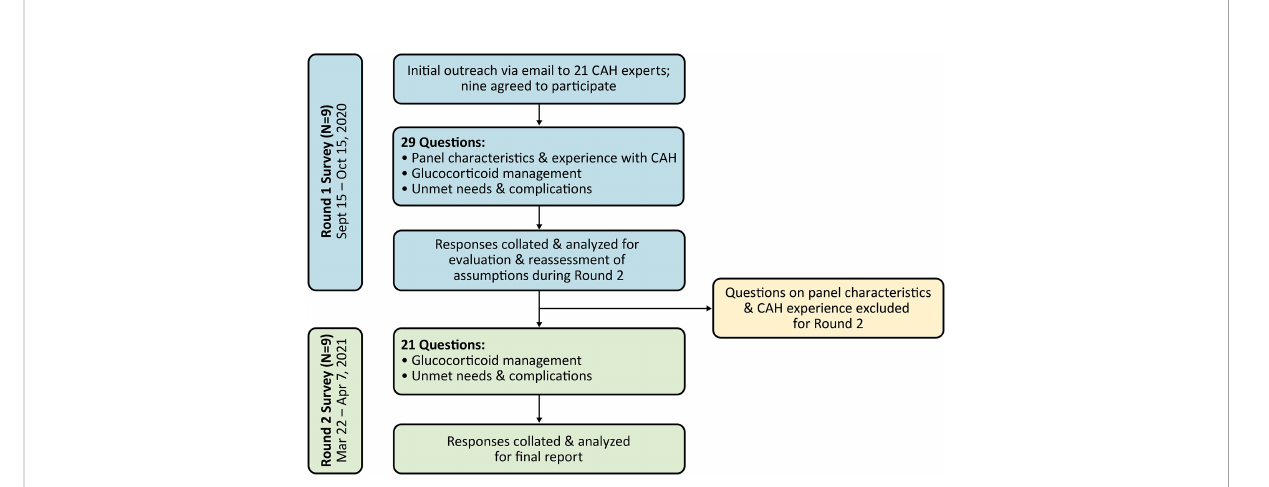
FIGURE 1 Flowchart of modi fi ed Delphi panel process. CAH, congenital adrenal